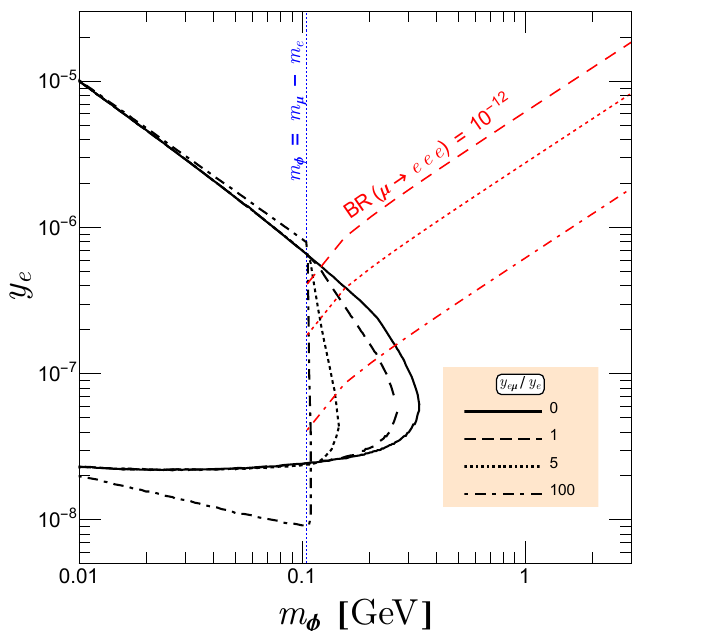
Figure 6 . Exclusion region from the E137 experiment for the scalar interaction. The CLFV coupling is taken to y eµ /y e = 0 (solid), 1 (dashed), 5 (dotted), and 100 (dot-dashed). Red curves represent the constraints from µ → eee , and blue vertical line corresponds to m φ = m µ − m e